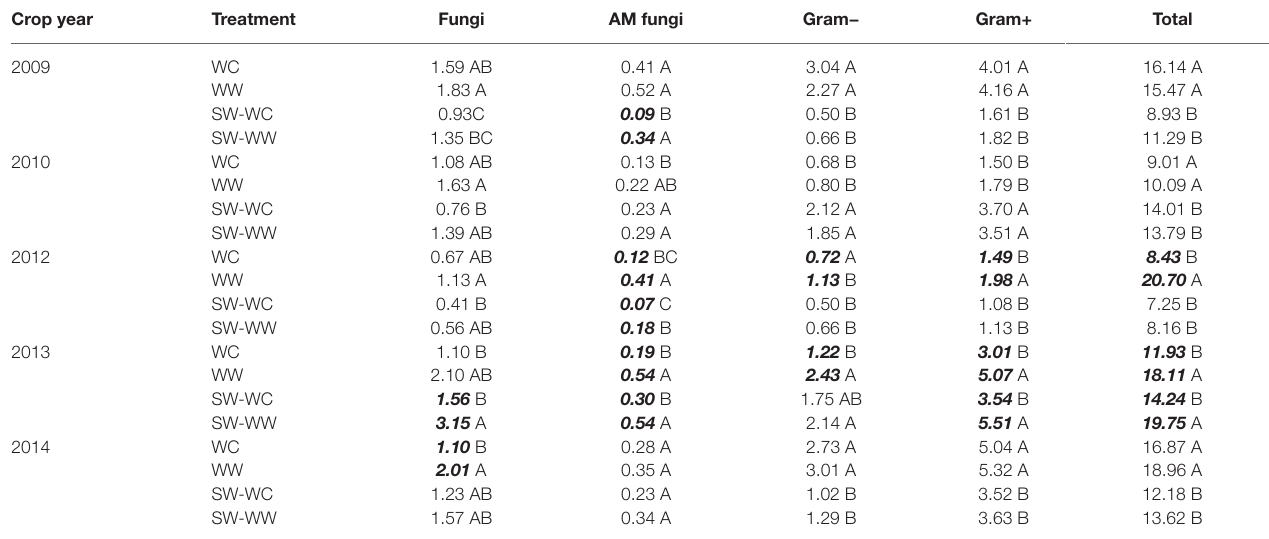
TABLE 3 | Absolute abundance (nmol/g) of microbial lipid groups at 0–5 cm depth from each crop year